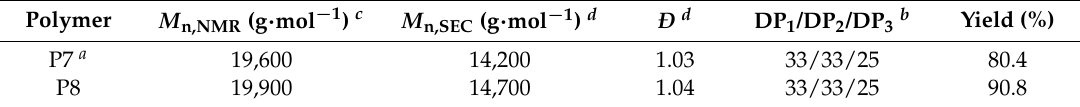
Table 3. Characteristics of P7 and P8